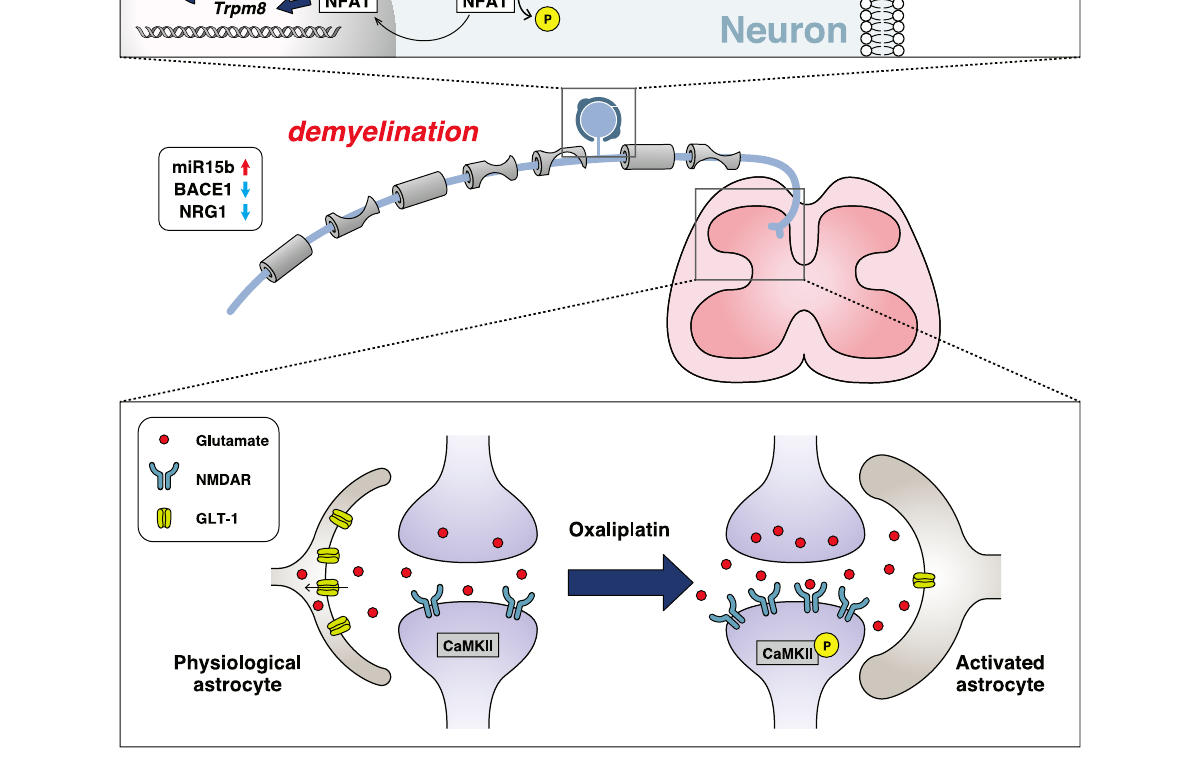
Frontiers in Pharmacology |